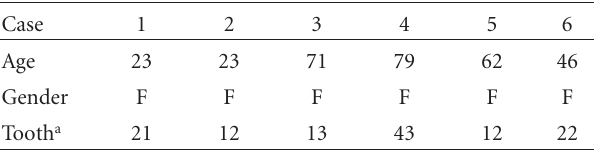
Table 1: Clinical features of